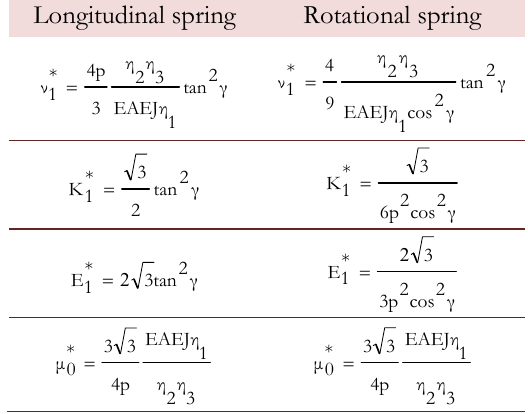
Table 1: Explicit expression of the coefficients in the asymptotic formulae in eqn. (23). In the table η 1 =3EJ+p 2